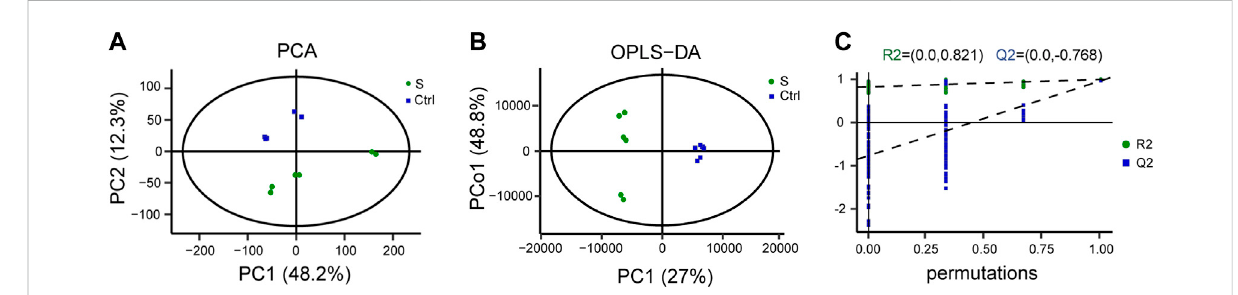
FIGURE 2 LC-MS-based metabolomic analysis of the hippocampus inthe SAE (S) and control groups (Ctrl). (A) Principal component analysis (PCA) scores plot ( n = 6). (B) Ortholog partial least squares-discriminate analysis (OPLS-DA) scores. (C) The permutation